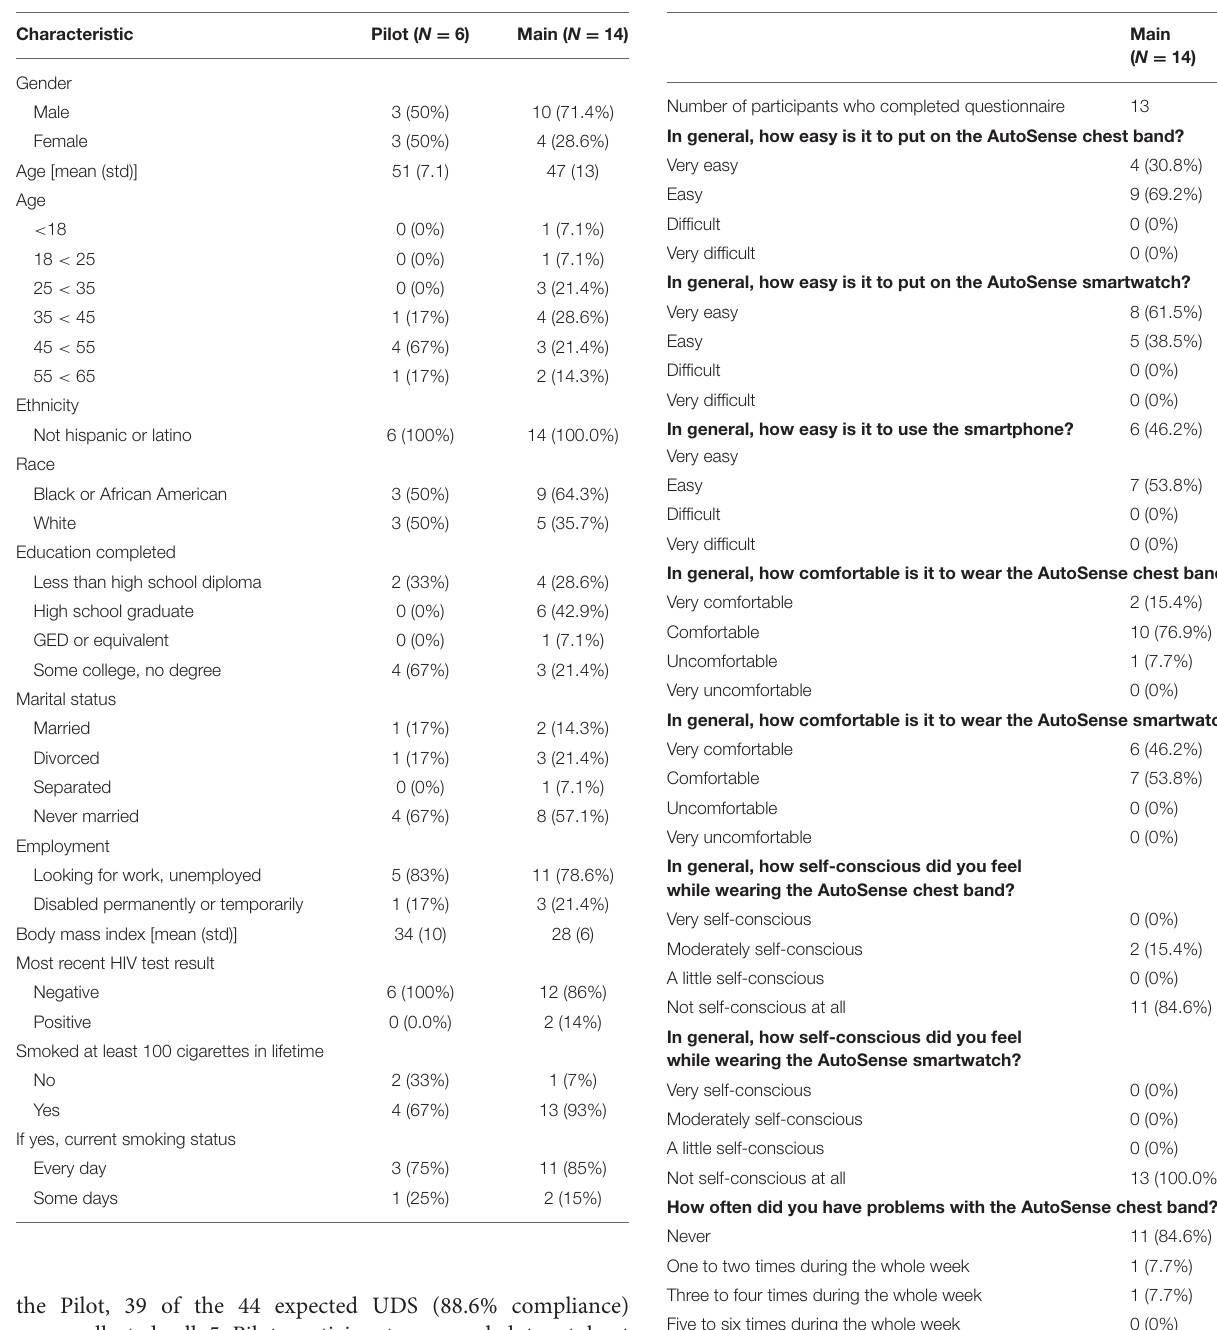
TABLE 1 | Participant demographics and characteristics. TABLE 2 | AutoSense usability